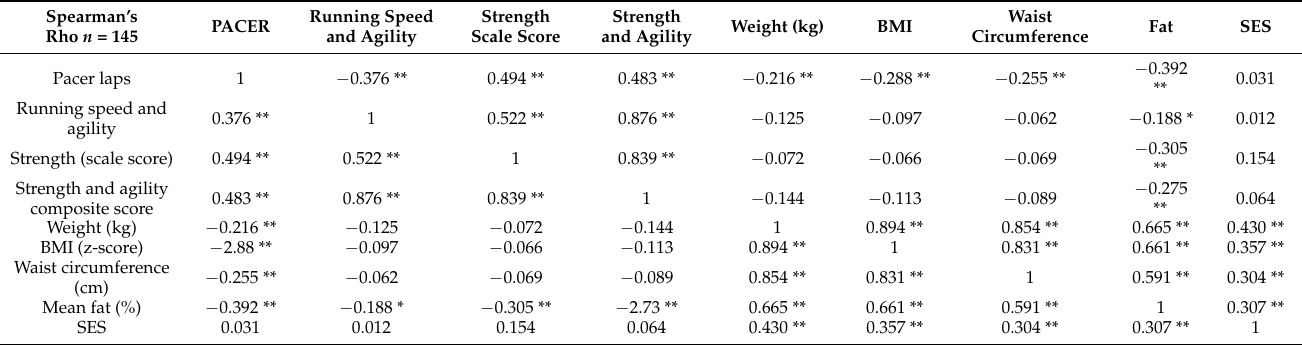
Table 5. Interrelation between health-related fitness outcomes and